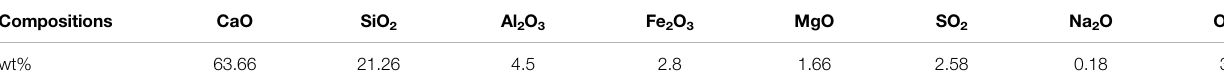
TABLE 3 | The chemical composition of cement.